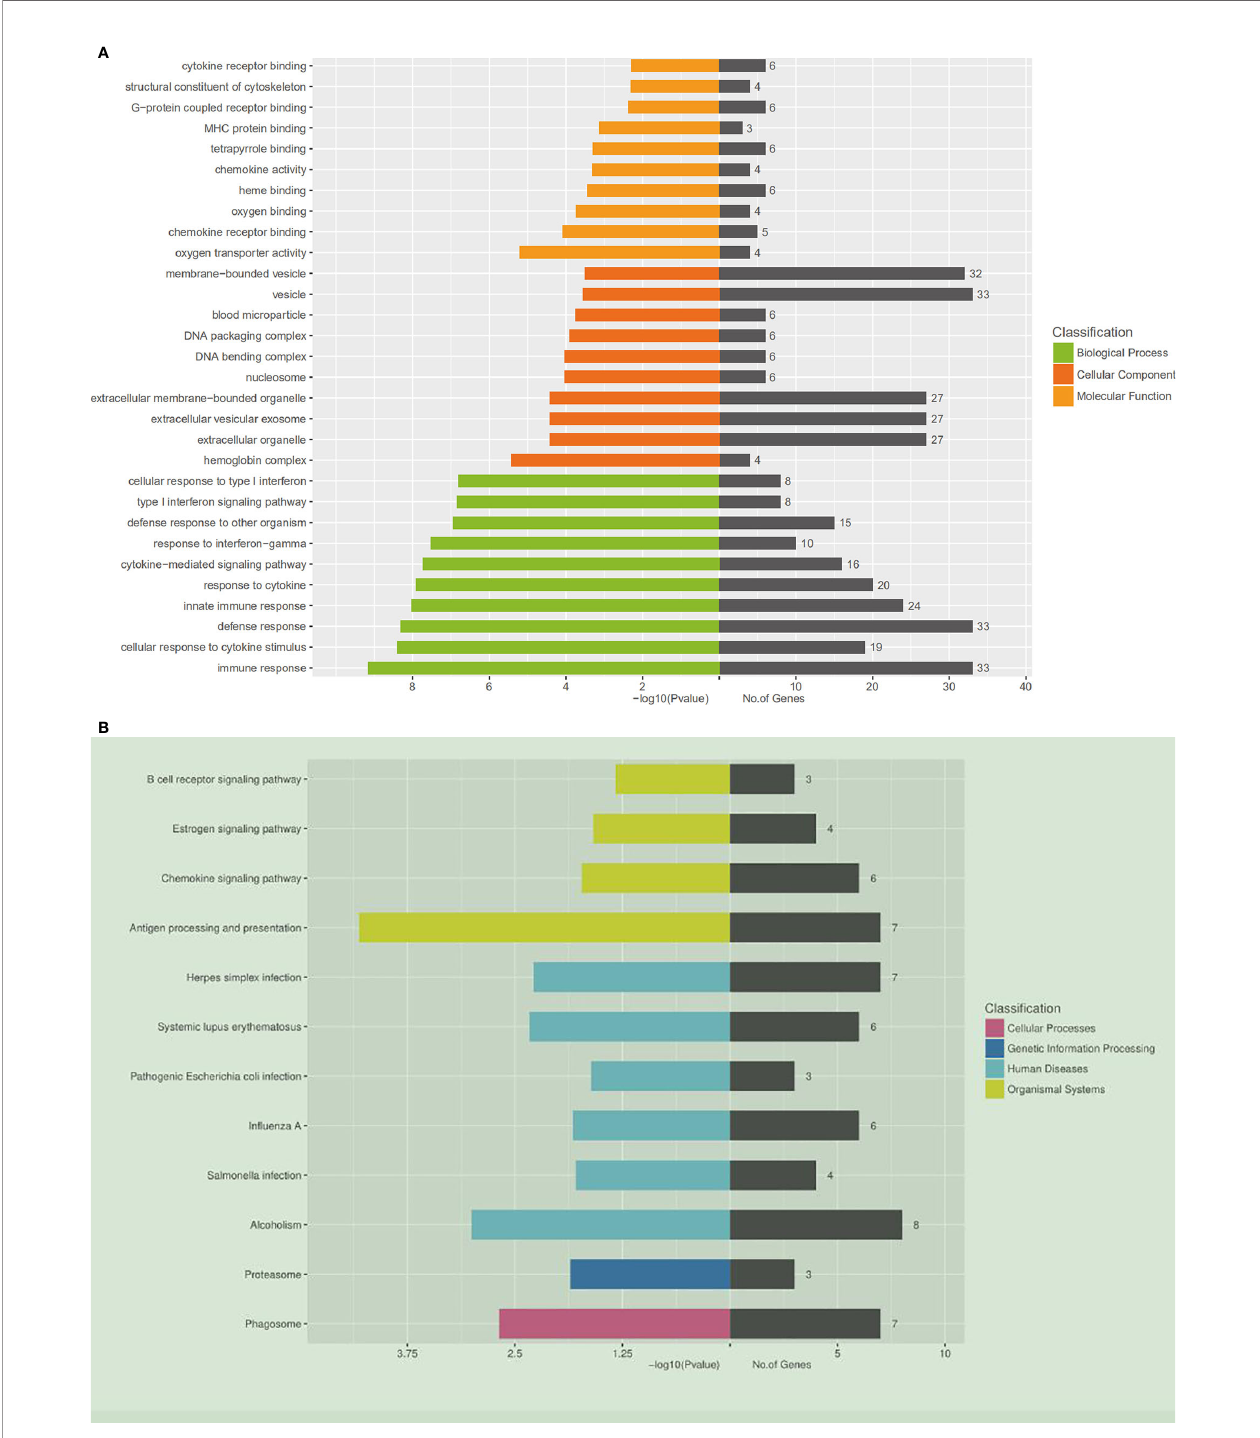
FIGURE 2 | Gene ontology and KEGG pathway analysis of differentially expressed mRNAs. (A) Gene ontology. A total of 409 differentially expressed mRNAs are chosen in GO analysis, which are divided into three categories: the green columns represent the top 10 biological processes, the red represents the top 10 cellular components, and the orange represents the top 10 molecular functions. On the right side of the coordinate axis, the gray color represents the number of genes enriched in the pathway. (B) The KEGG pathway enrichment analysis was performed on the KEGG biological pathways database (http://www.genome.jp). The left side of the coordinate axis shows the P-values of the pathway, and the yellow, green, blue and purple colors indicate the KEGG classi fi cation: organismal systems, human diseases, genetic information processing and cellular processes. On the right side of the coordinate axis, the gray color represents the number of genes enriched in the